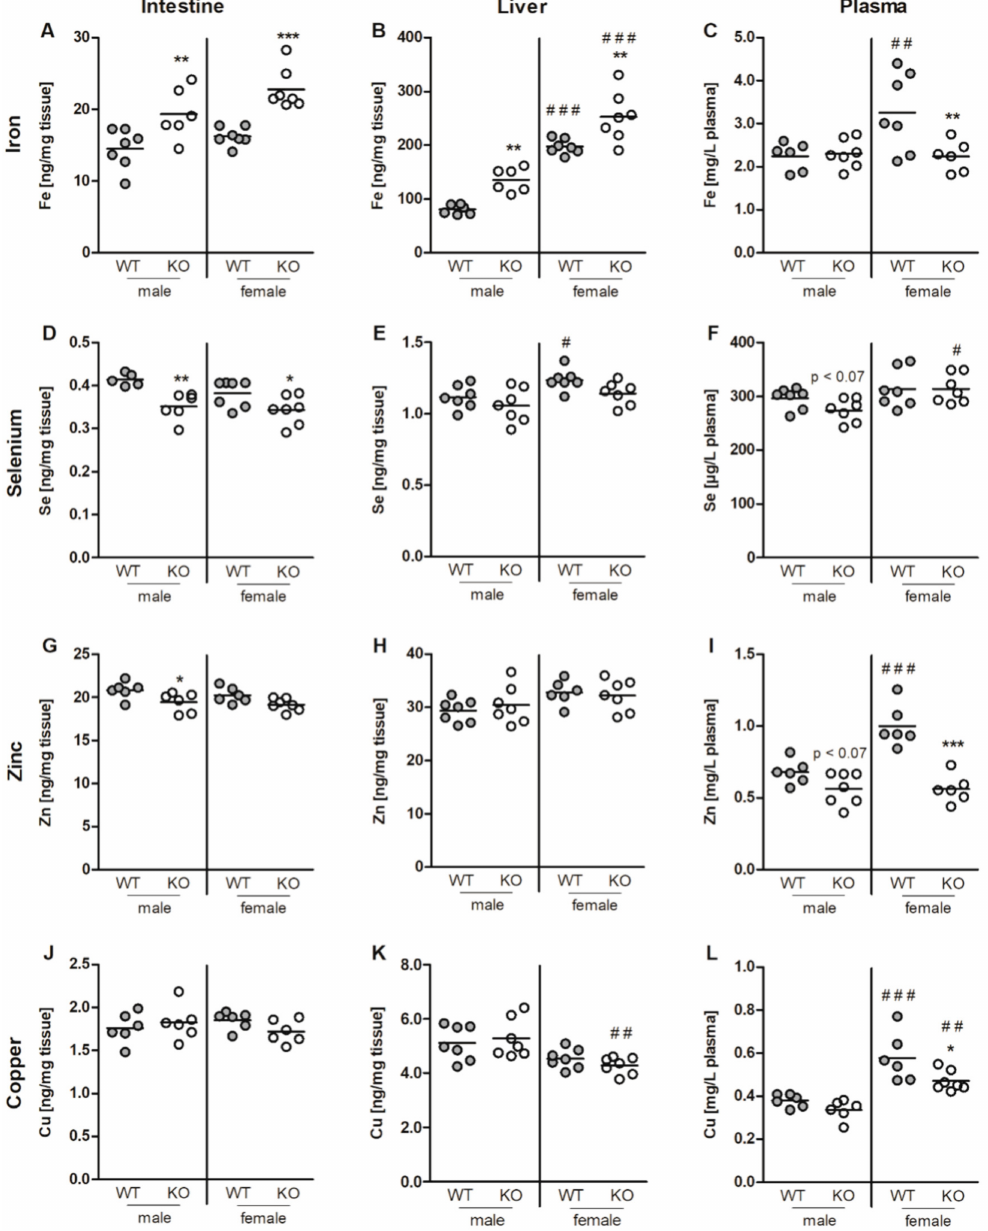
Figure 1. Fe ( A – C ), Se ( D – F ), Zn ( G-I ), and Cu ( J – L ) concentrations in the jejunum ( A , D , G , J ), liver ( B , E , H , K ), and plasma ( C , F , I , L ) of six-month-old male and female Nrf2 KO and WT mice fed a standard chow diet with 0.3 ppm Se. The TE profile was analyzed using ICP-MS / MS. Scatter dot plots with mean ( n = 6–7). * p < 0.05; ** p < 0.01; *** p < 0.001 vs. WT and # p < 0.05; ## p < 0.01; ### p < 0.001 vs. male (two-way ANOVA with Bonferroni’s